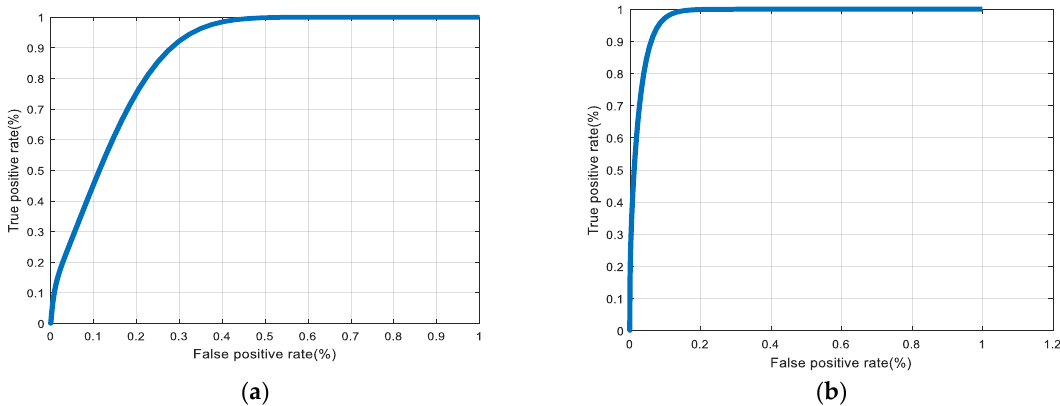
Figure 20. ROC curves for the system using an encrypted kernel in the DWT with similar keys of encryption with a noise variance of ( a ) 0.01, and ( b ) 0.02.